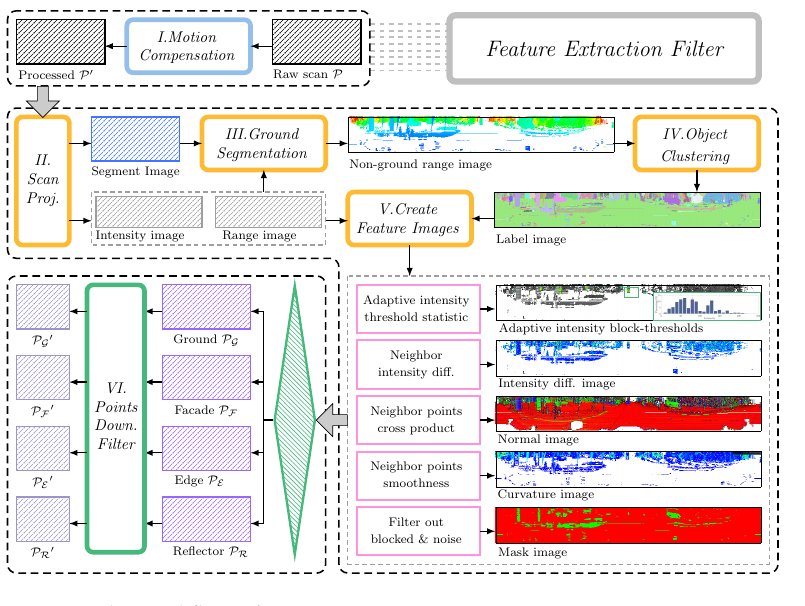
Figure 3. The workflow of